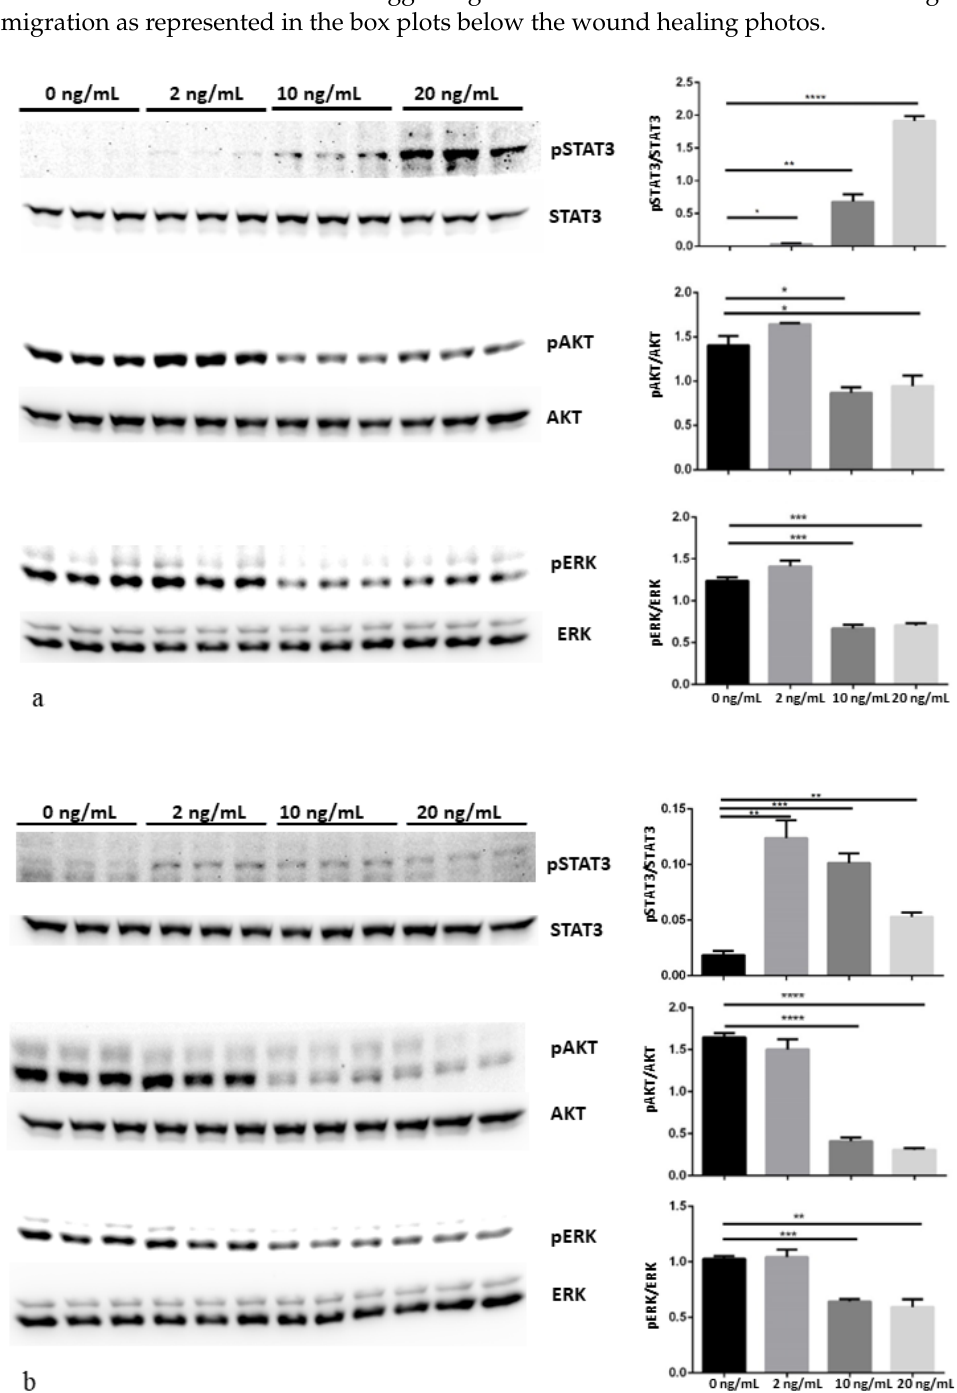
Figure 3. Dose-dependent response to rhCNTF of JAK/STAT3, PI3K/Akt and MAPK/ERK proteins pathways in LNCaP ( a ) and 22Rv1 ( b ) prostate cancer cell lines by Western blot analysis. LNCaP and 22Rv1 cell lines were treated with 0, 2, 10 and 20 ng/mL rhCNTF for 15 min. Bands were quantified and results were calculated in arbitrary units (AU) and reported as bars of a histogram. pSTAT3, pAKT and pERK1/2 quantities were normalized using total STAT3, AKT and ERK1/2, respectively. Data are represented as mean ± SD. * p < 0.05, ** p < 0.01, *** p < 0.001, **** p < 0.0001. Original images of immunoblotting data in the Figure S1.